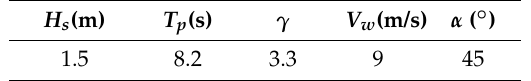
Figure 11. The variation of the current velocity at different water depths.